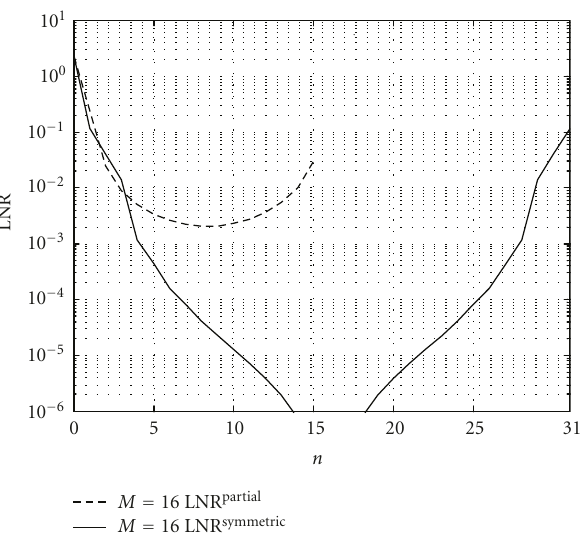
Figure 6: Theoretical MSE of conventional partial frequency response DFT-based channel estimator.